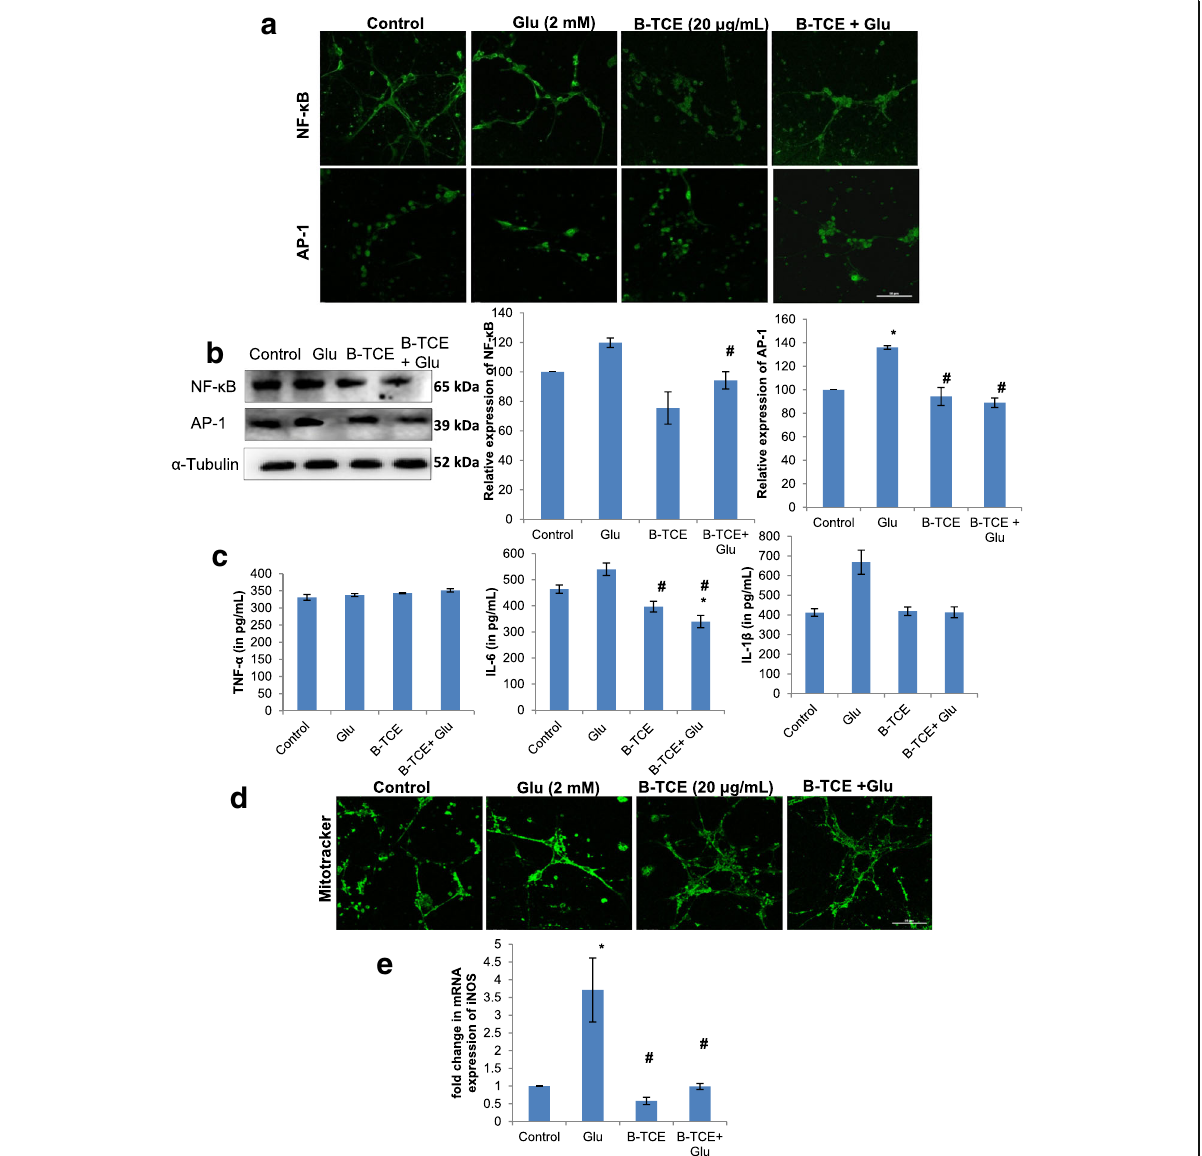
Fig. 3 B-TCE pretreatment abolished the glutamate-induced onset of inflammation. a ) Confocal micrographs of Control, Glutamate (2 mM), B-TCE (20 μ g/mL) and B-TCE + Glu treated primary cerebellar neurons immunostained for NF- κ B and AP-1. b ) Representative immunoblots and histograms showing relative expression of NF- κ B and AP-1 where α -Tubulin was used as internal control. c ) Histograms representing secretory levels of pro-inflammatory cytokines TNF- α , IL-6 and IL-1 β (in pg/mL) in the four different treatment groups. d ) Confocal micrographs of primary cerebellar neurons stained with Mitotracker green FM e ) Histogram representing fold change in mRNA expression of iNOS in four different treatment groups. Data was compared between Control and other groups such as Glutamate, B-TCE and B-TCE + Glu ( * p ≤ 0.01) as well as Glutamate alone with B-TCE and B-TCE + Glu groups ( # p ≤ 0.01). Confocal Images were captured at 60X objective (Scale bar: 50 μ